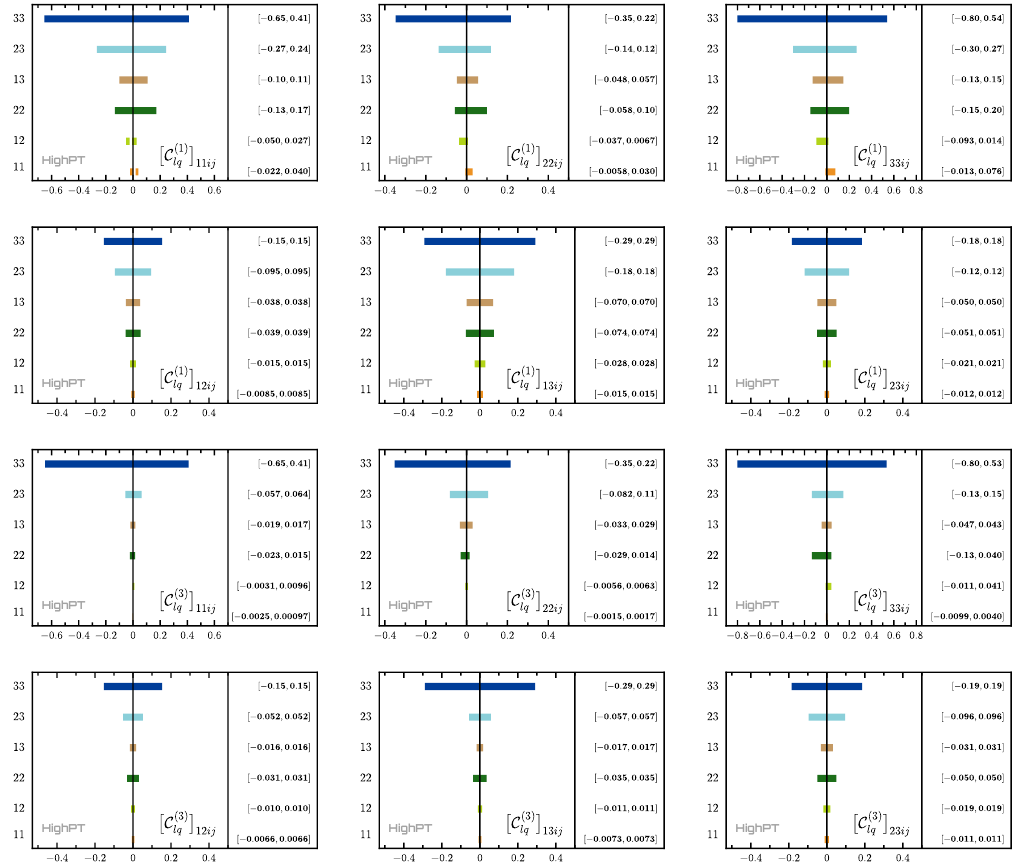
with different flavor indices lq